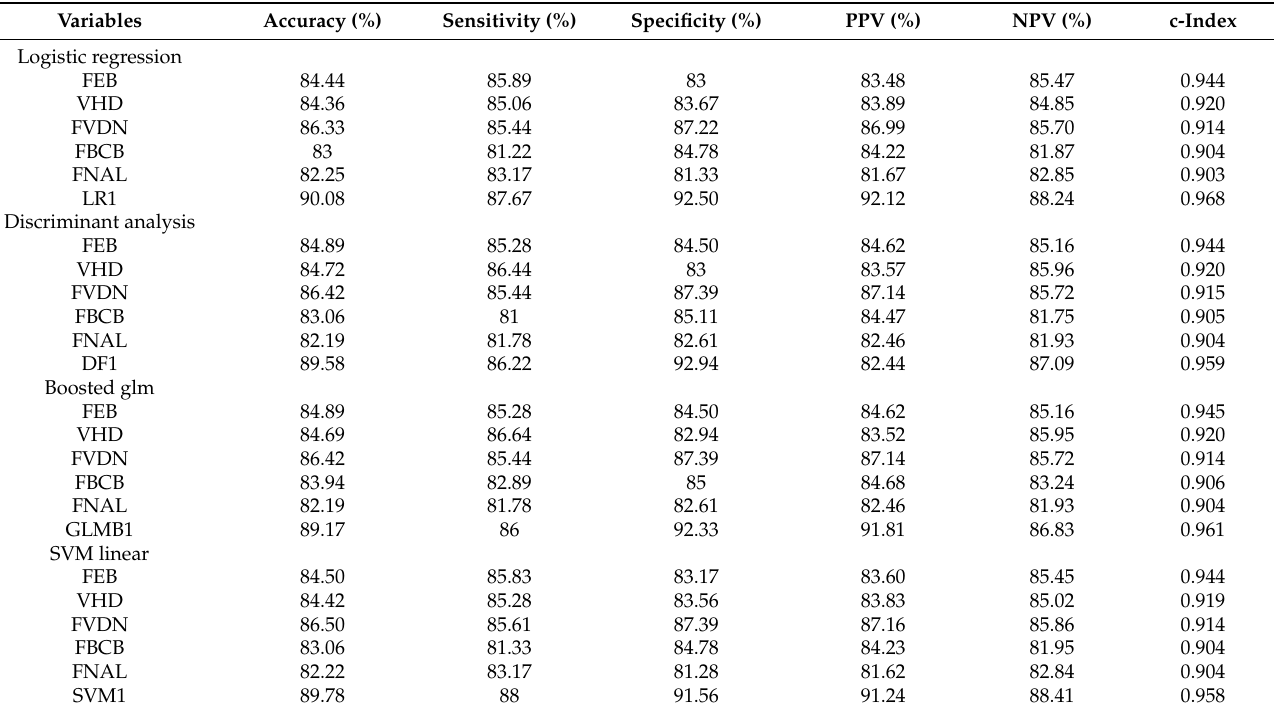
Table 2. LGOCV classification results without employing the ABC approach in the training sample.